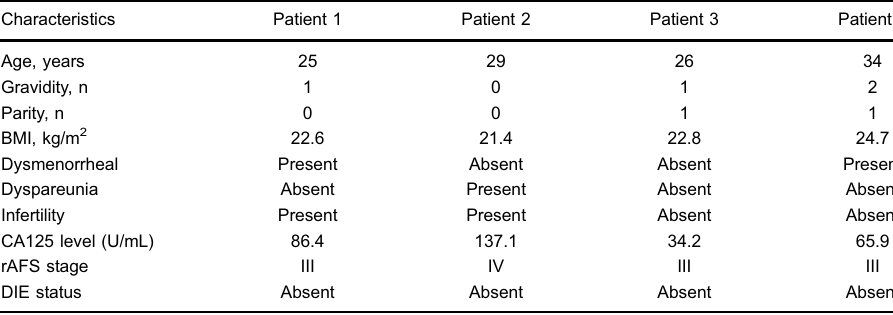
Table 1. Clinical characteristics of the patients with